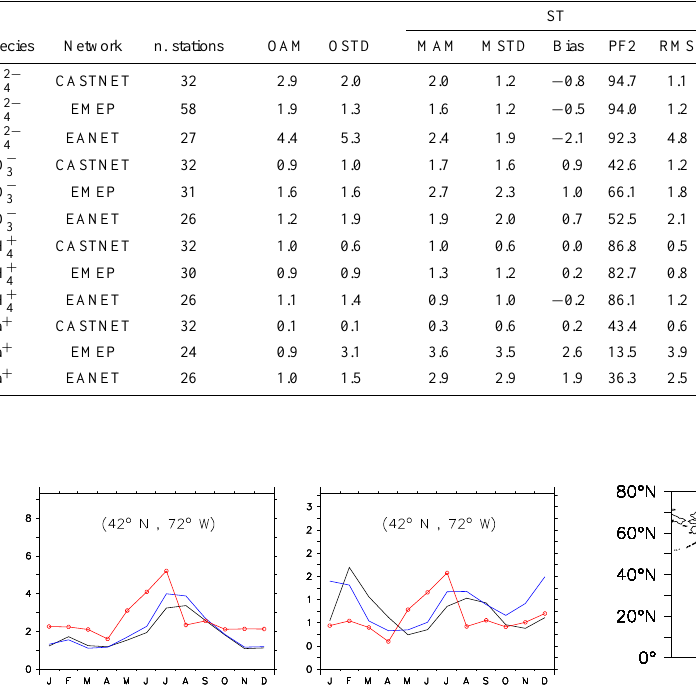
Fig. 16. Comparison of simulated and observed SO 2 − NH + (right) concentrations (in µgm − 3 ) for a selected location of 4 the CASTNET observational network. The red lines represent the observations, while the simulated monthly averages are indicated by the black and blue lines for simulation ST and NS respectively. The location of the station (longitude and latitude) is indicated. Note the different scales of the vertical axes.